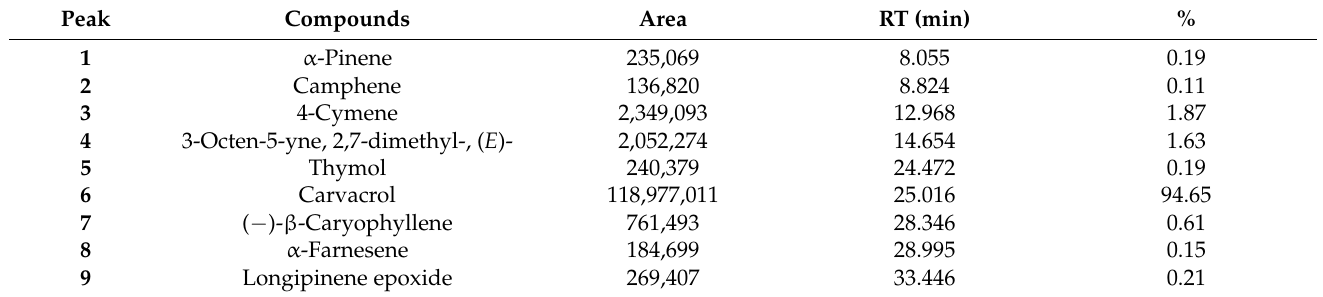
Figure 2. HPTLC chromatogram and peak areas of carvacrol in samples. (T: Thymol, C: Carvacrol, E.O.: Essential oil, S: Sample). Table 1. Composition of the oregano essential oil used in this study .